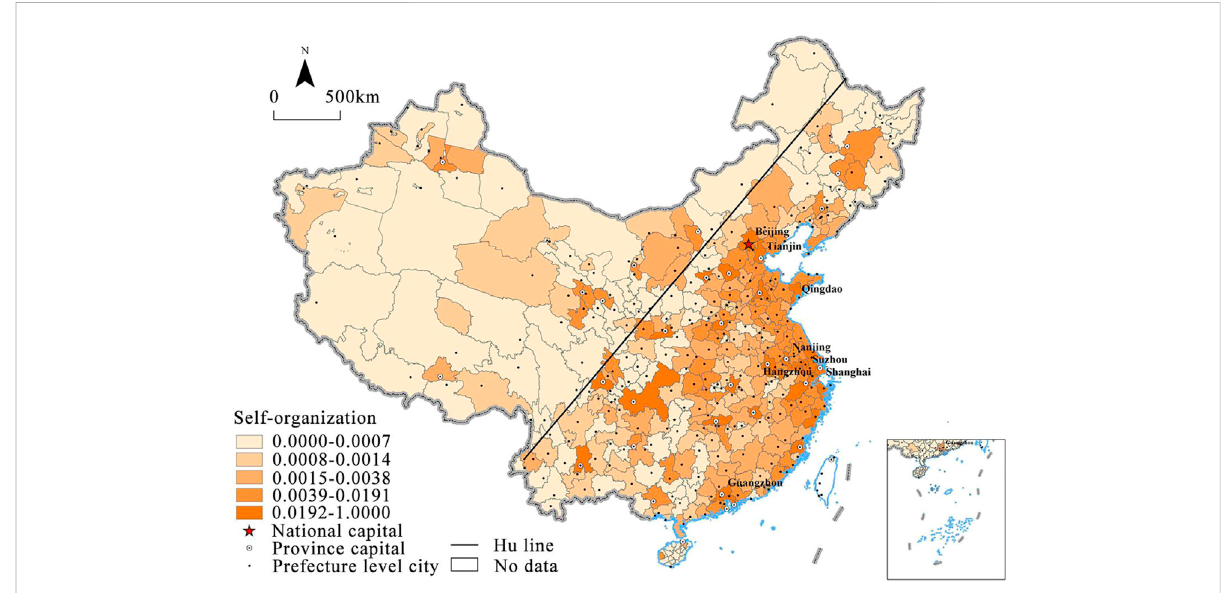
Spatial distribution of the self-organization of China ’ s urban innovation network.